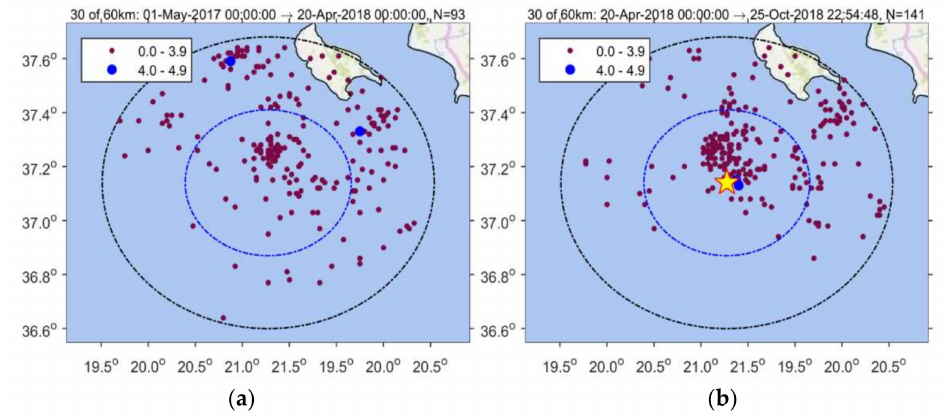
Figure 12. Seismicity at radii of 30 km and 60 km around the 25 October 2018 mainshock epicenter from 1 May 2017 up to 20 April 2018 (background seismicity BGS 2) ( a ), and from 20 April 2018 up to 25 October 2018 just prior to the mainshock occurrence (cluster 1) ( b ). Color panel shows scaling of earthquake magnitude size; star is mainshock